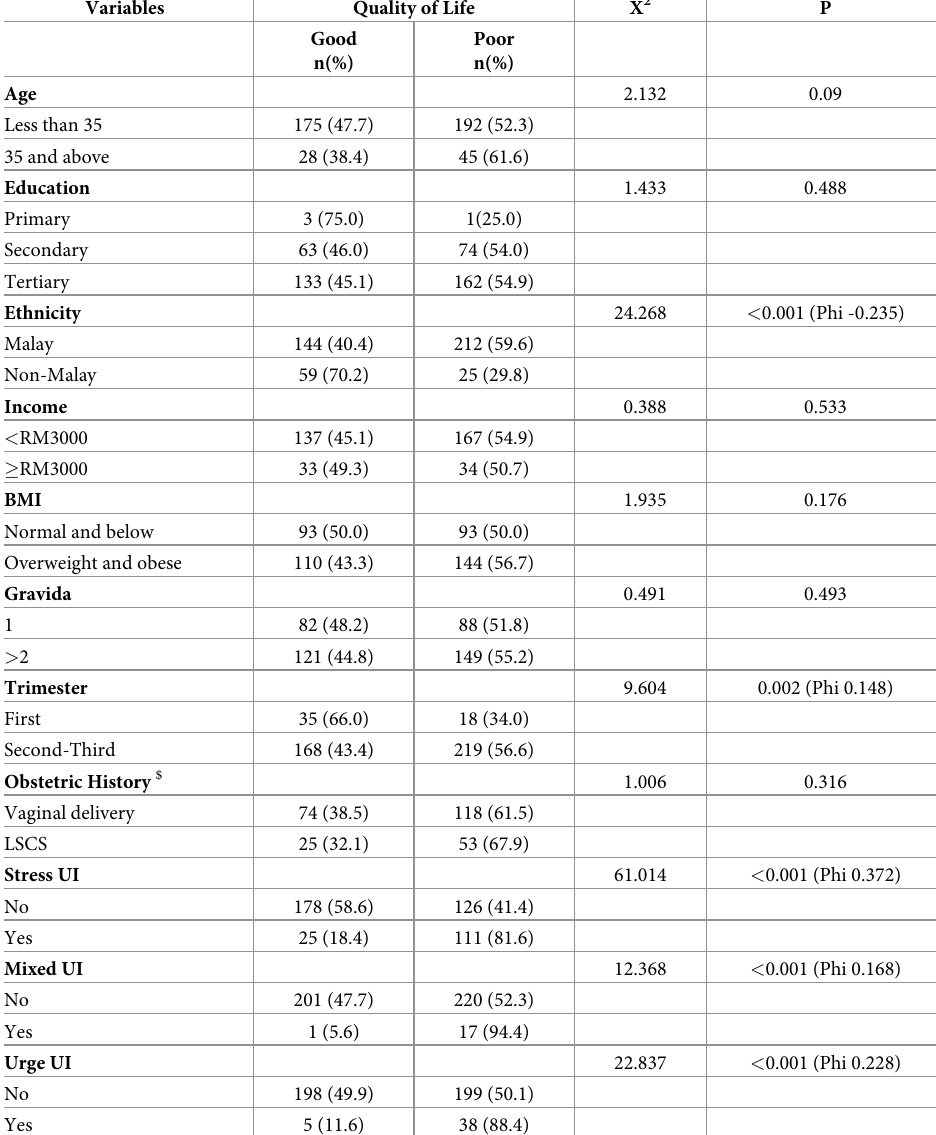
Table 2. Associations with quality of life of the respondents (N =